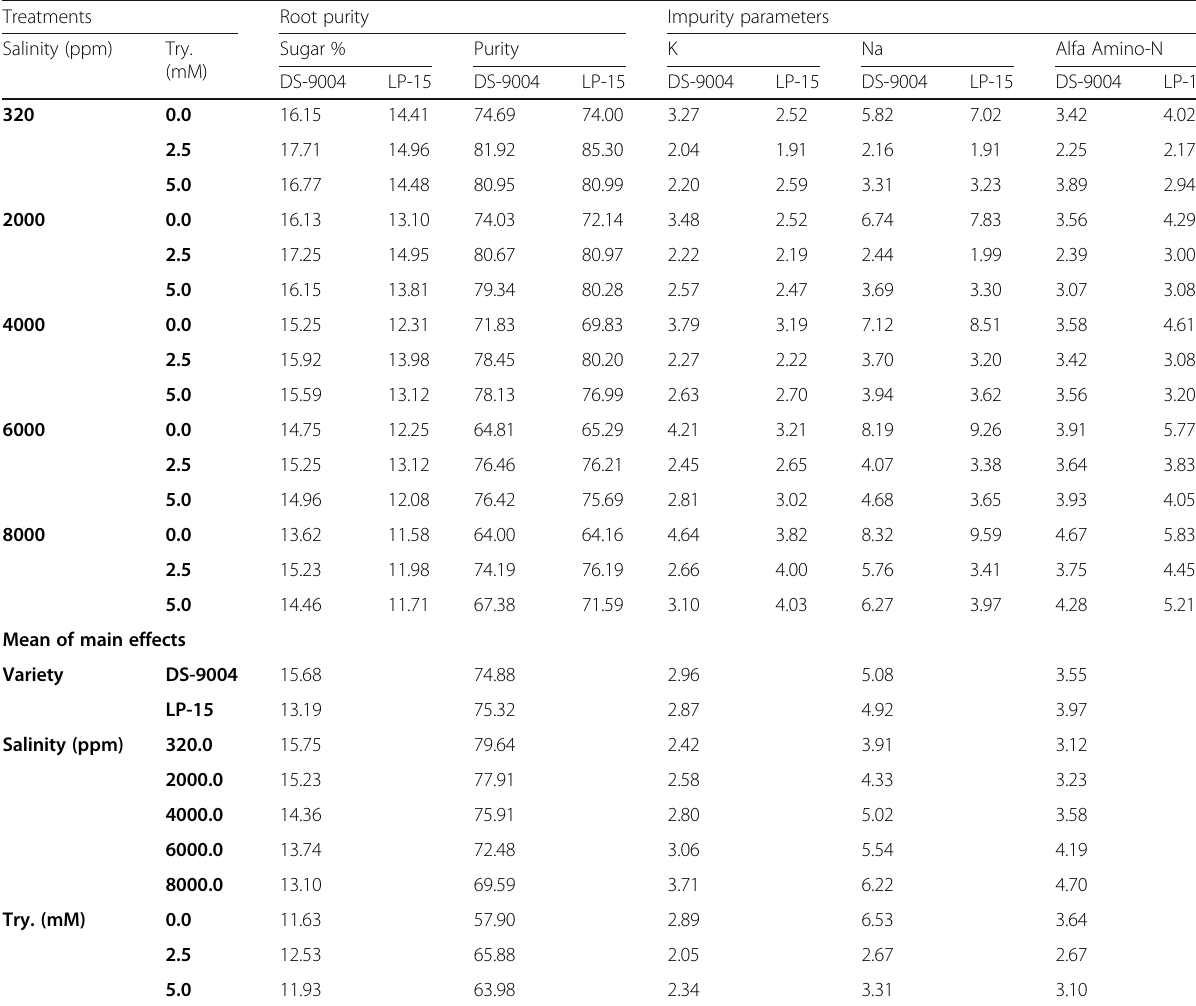
Table 6 Effect of soaking two sugar beet seed cultivars with tryptophan and irrigated with different salinity levels on root quality parameters at harvest (180 days after sowing) Treatments Root purity Impurity parameters Salinity (ppm) Try. (mM)